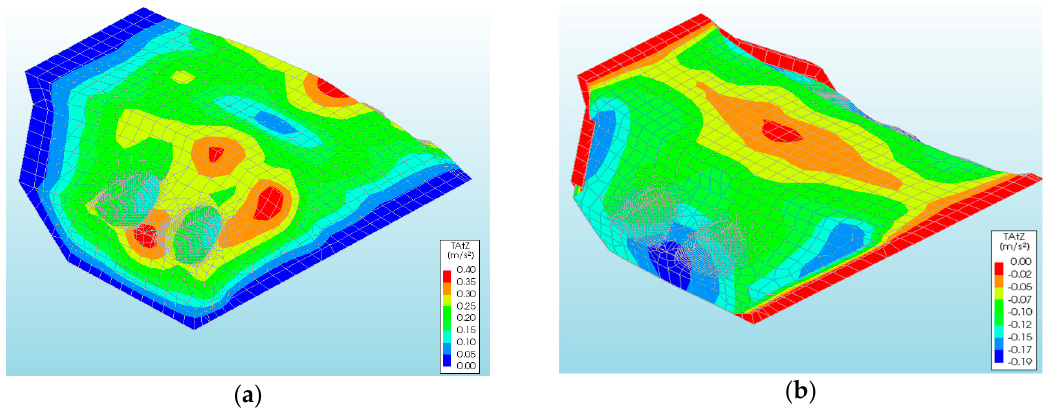
Figure 14. Distribution of backfill acceleration of rockburst for bridge models: ( a ) Ia and ( b ) VIa.